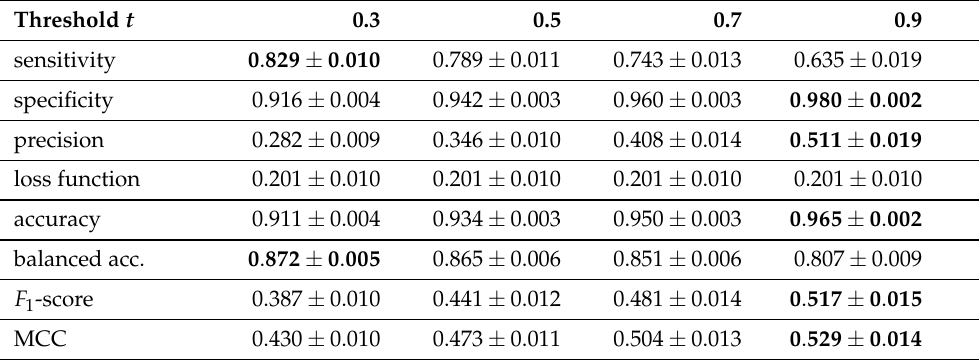
Table 4. Values of the observed performance metrics for different thresholds t . Values in table cells are in the form average ± standard deviation and are computed on 10 models obtained from independent test sets. The best values for each metric are denoted with